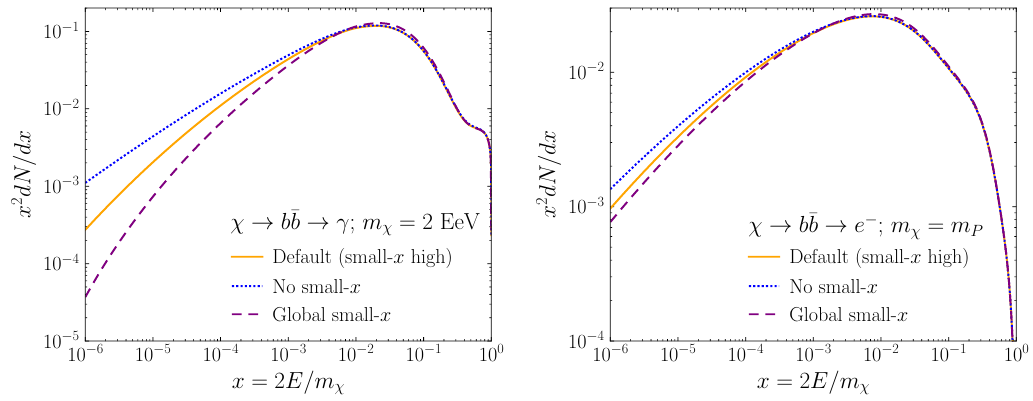
Figure 11 . An estimate of the uncertainty associated with our treatment of the small- x physics. We achieve this by showing results for three different treatments of soft coherence, for the spectra resulting from χ → b ¯ b for two different masses and final states: the photon spectrum for m = 2 EeV χ (left), and the electron spectrum for m = m (right). In dotted blue, we show the result of applying χ P no corrections at all, a result which represents an undoubted overestimate of the small- x flux. In solid orange we show our default procedure of applying a substitution m in the high scale χ → xm χ FF, as outlined in appendix B.2. Finally, in dashed purple we show the result of applying that same substitution to our full FF that results from the convolution of all three steps. This final result will double-count soft-coherence from the low-scale evolution, and therefore sits below the other approaches. We see that at an EeV, and for x ∼ 10 − 6 the uncertainty is at the order-of-magnitude level. For x & 10 − 3 or at higher masses, the result reduces to a O (1)